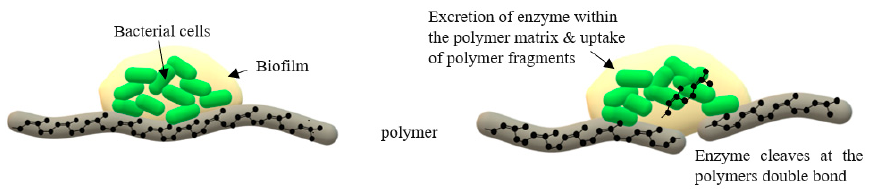
Figure 3. Microbial producing biofilm for attachment and enzyme excretion onto the polymer surface.